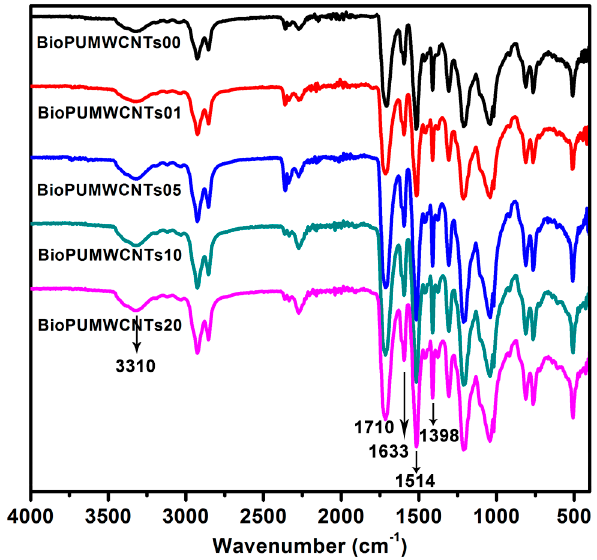
Figure 5. Fourier transform infrared (FTIR) spectra of the nanocomposite bioplastics